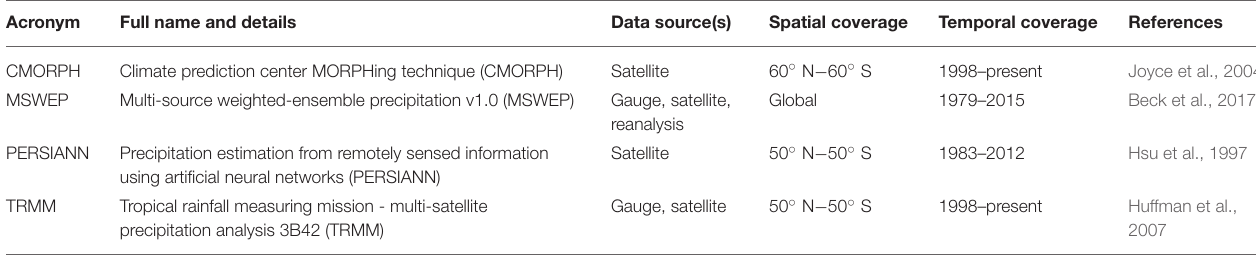
TABLE 2 | Satellite-derived precipitation data.